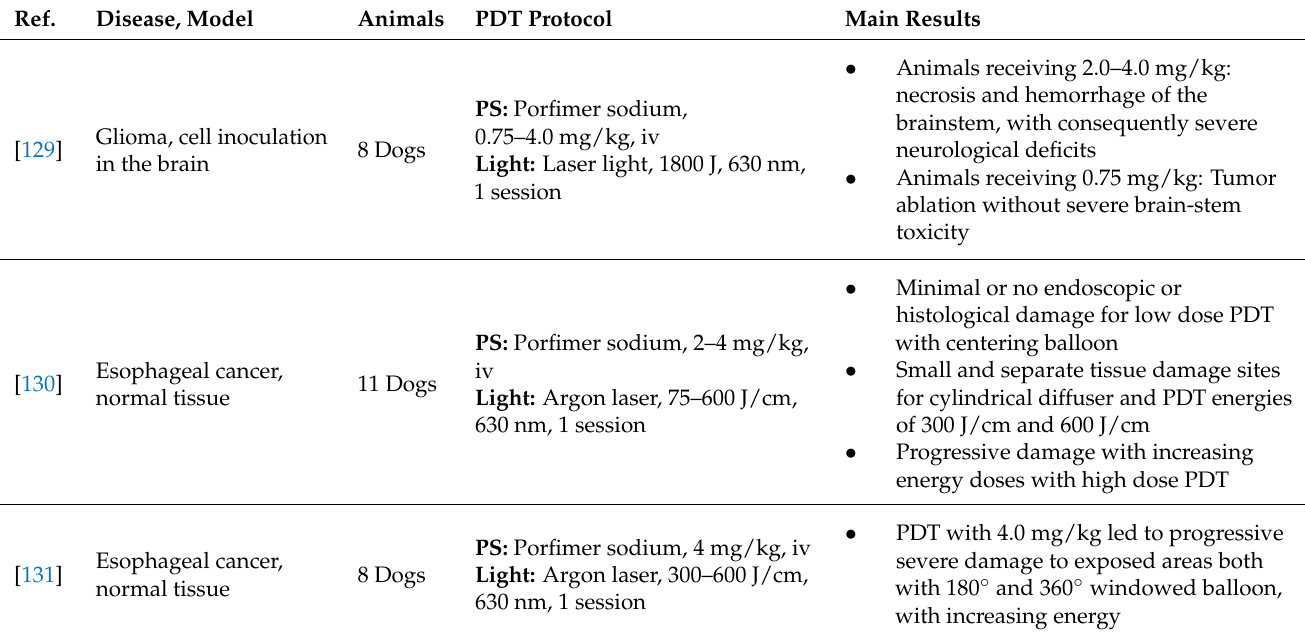
Table 6. Studies on healthy dogs and cats as preclinical